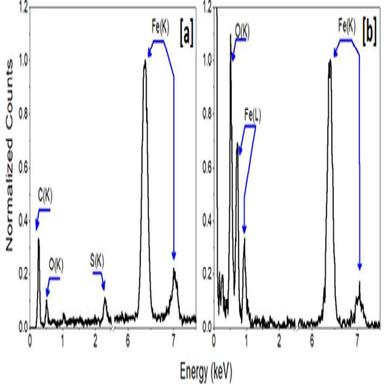
EDX spectra of (a) nZVSI and (b) nZVI, obtained during the SEM analysis, each spectrum was normalized on the most intense Fe(K) peak.